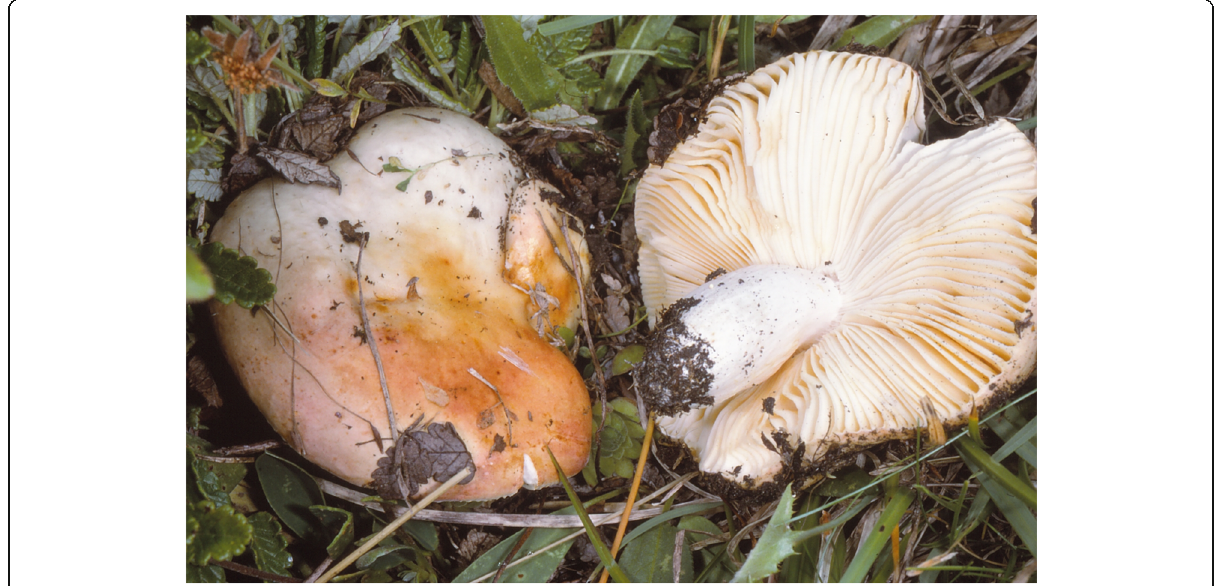
Fig. 2 Russula dryadicola (LIP PAM95082603), field appearance. Bar = 1 cm. Photo: P.-A.